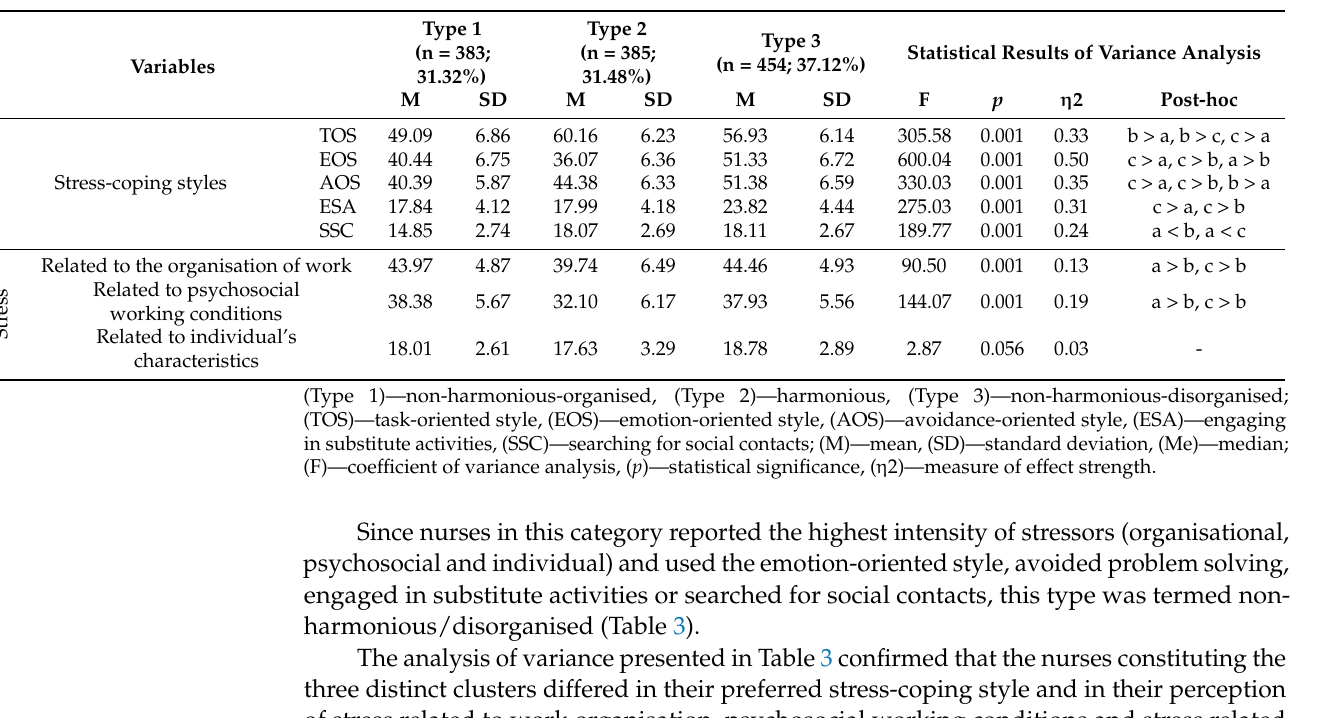
Table 3. Comparative analysis between nurses functioning according to the three types of stress- coping strategies in terms of coping styles and specific types of stress.